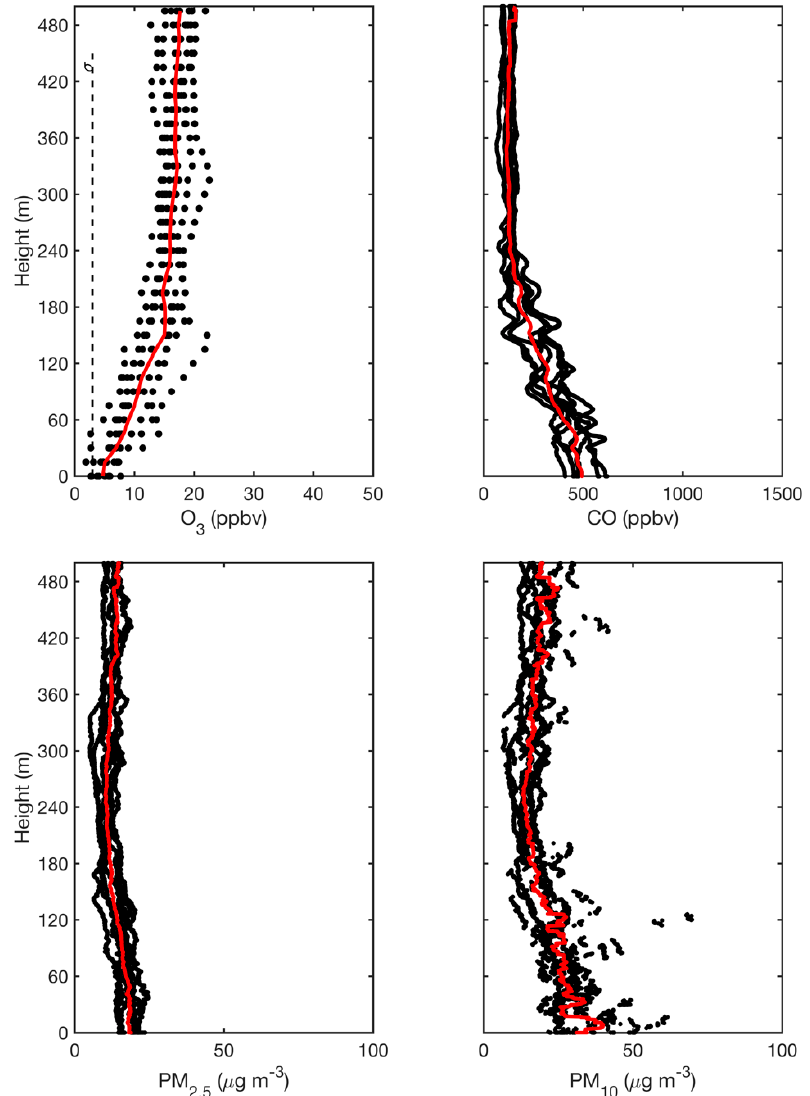
Figure 4. Vertical profiles of the concentrations of ozone, carbon monoxide, PM 2.5 , and PM 10 from land surface to an altitude of 500 m for 8 flights on 29 September 2018 between 20:00 and 00:00 (LT). The red line represents the median of the data at each altitude. The dashed line represents the instrumental limit of detection for ozone (3 ppbv). Individual profiles are plotted in Figure S2.